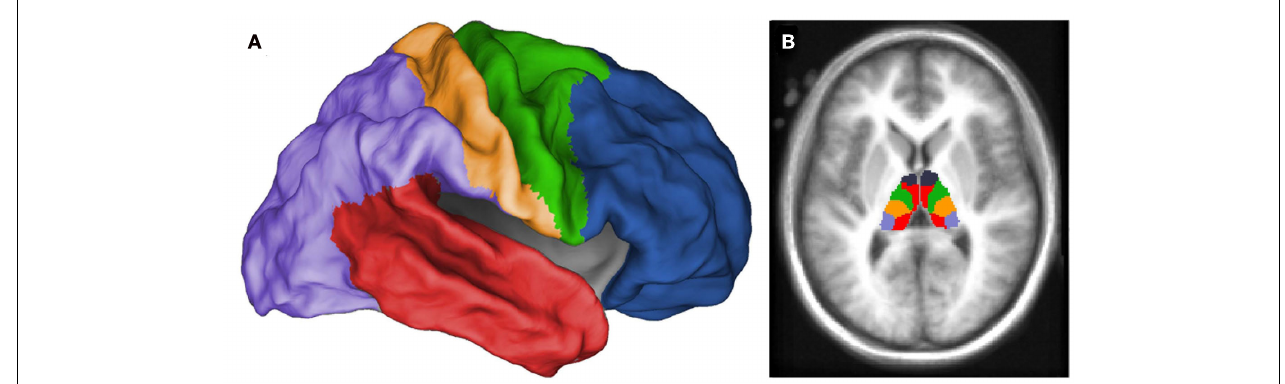
most strongly correlated. Cortical subdivisions are illustrated in (A) , and the thalamic subdivision is illustrated in (B) .Thalamic ROIs were generated from this subdivision to analyze the functional connectivity of distinct thalamic